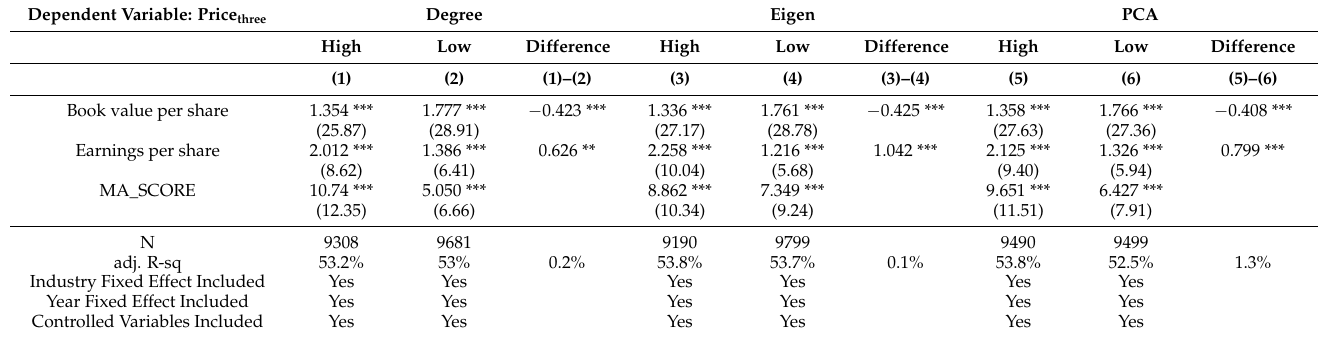
Table 7. CEO social capital and the value relevance of accounting metrics: controlling for managerial ability. This table presents the results of the OLS regressions explaining the effect of CEO social capital on the value relevance of book value of equity and earnings metrics, controlling for managerial ability. The dependent variable is Price three , a continuous variable measured by the market price of the common equity at the end of three months after fiscal year-end. CEO social capital is measured by Degree in columns (1) and (2), Eigen in columns (3) and (4) and PCA in columns (5) and (6); managerial ability is measured by MA_SCORE, as suggested by Demerjian et al. (2012). Variables of interest in the regression include Book value per share (book value of common equity scaled by number of shares outstanding) and Earnings per share (net income scaled by number of shares outstanding). All regressions include control variables as defined in Appendix A. For brevity, the table only presents coefficients related to the variables of interest. All regressions include time- and industry-fixed effects and the errors are robust to firm heteroscedasticity. T-values are reported in parentheses. Statistical significance of the coefficients is designated as *** and ** at 1% and 5% levels, respectively.